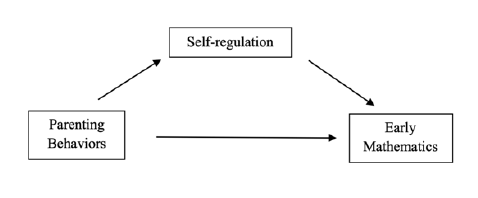
Relationship between parenting behaviors and early mathematics mediated by